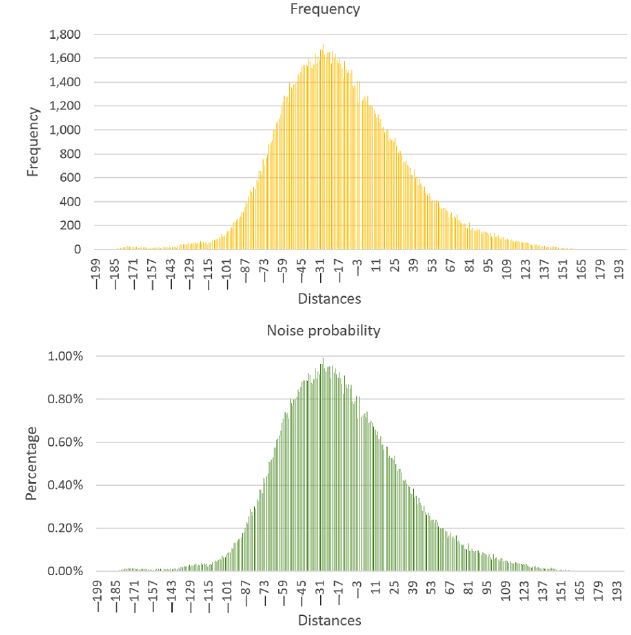
Figure 14. Process generating the noise distribution function.